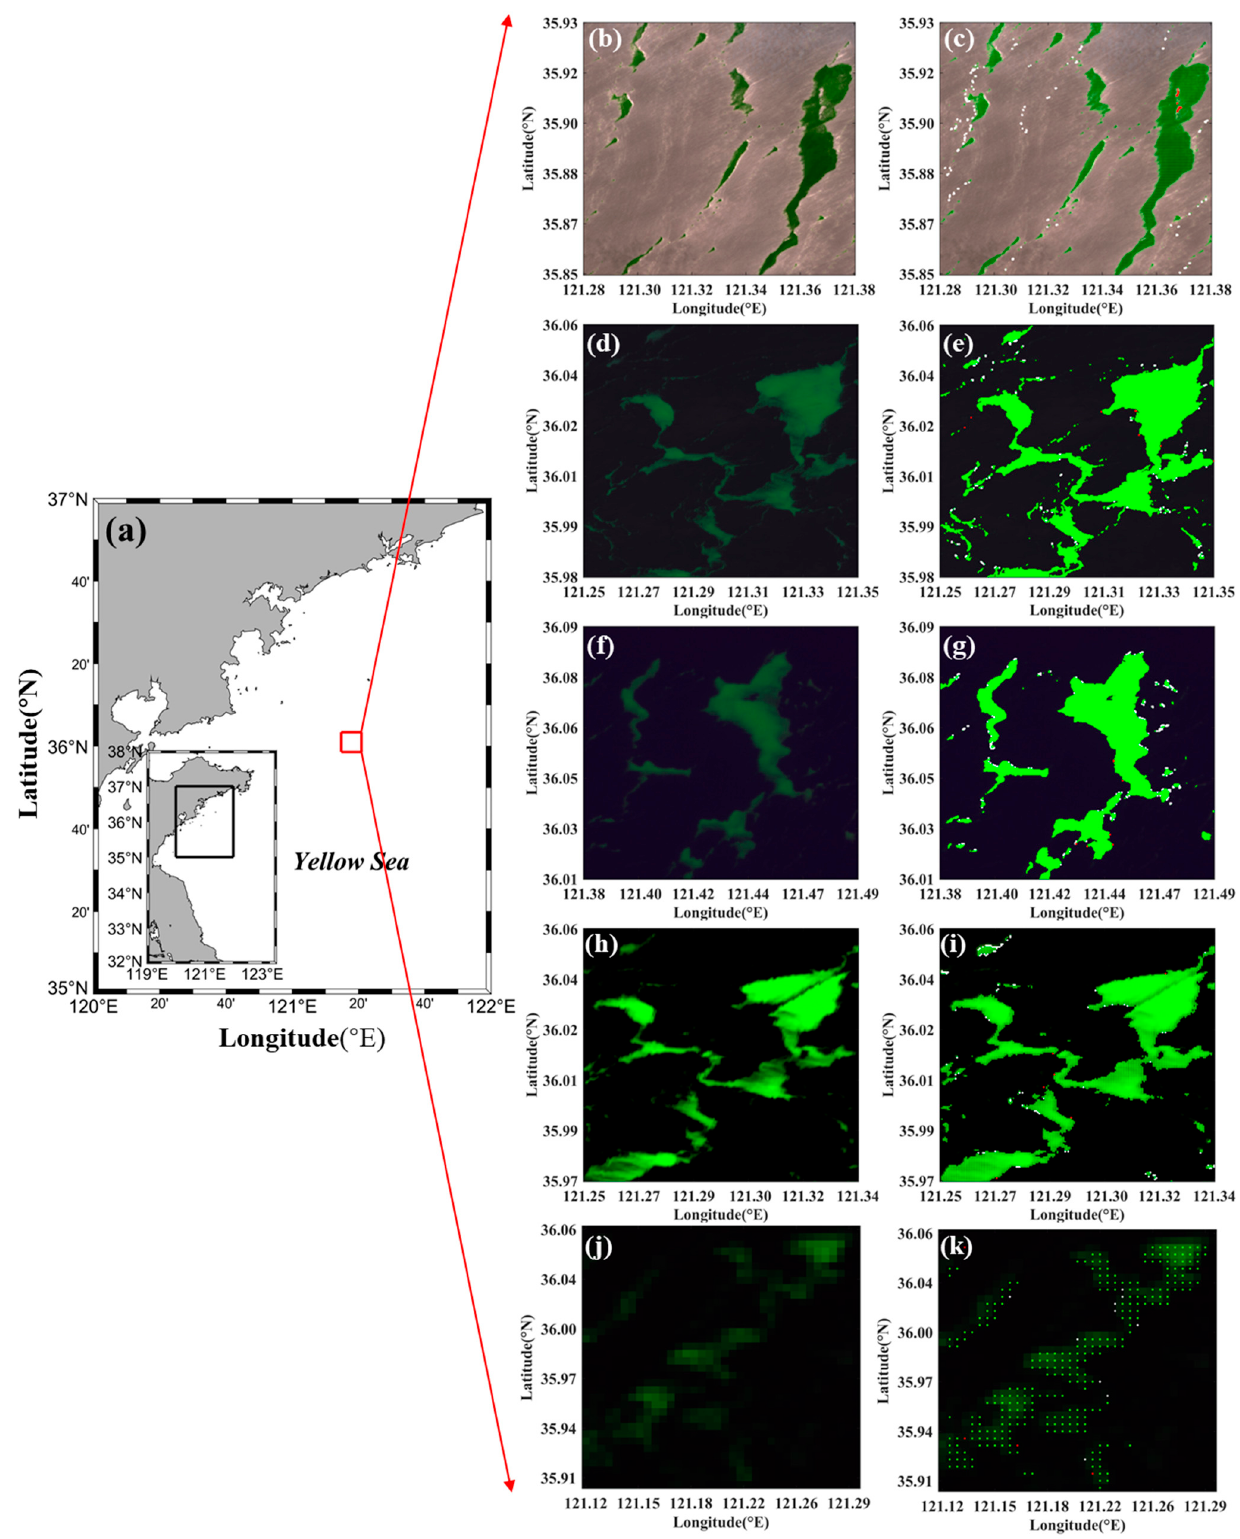
Figure 8. Schematic diagram of the location of the satellite extraction area. ( a ) is the selected approx- imate area; ( b , d , f , h , j ) are false-color images of GF-1, Landsat, HJ-1, HY-1C, and MODIS, respectively (band combination: GF-1: band 3-2-1; Landsat: band 4-5-3; HJ-1 and HY-1C: 3-4-2; MODIS:1-2-1); and ( c , e , g , i , k ) are the images’ respective green tide extraction e ff ects (the red point represents FP, the white point represents FN, and the green point represents TP).